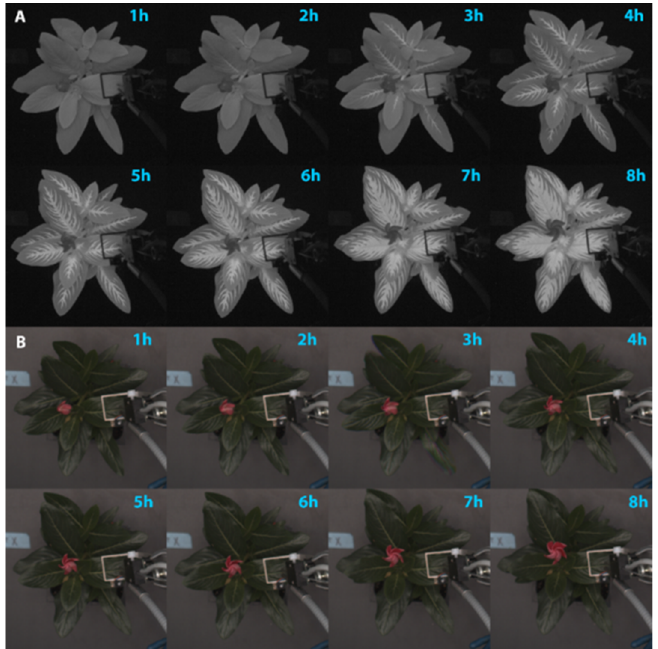
Figure 1. The effect of atrazine drench application on: ( A ) chlorophyll fluorescence and ( B ) visual appearance of Catharanthus roseus . Time since herbicide application is indicated in the upper righthand corner of each image.